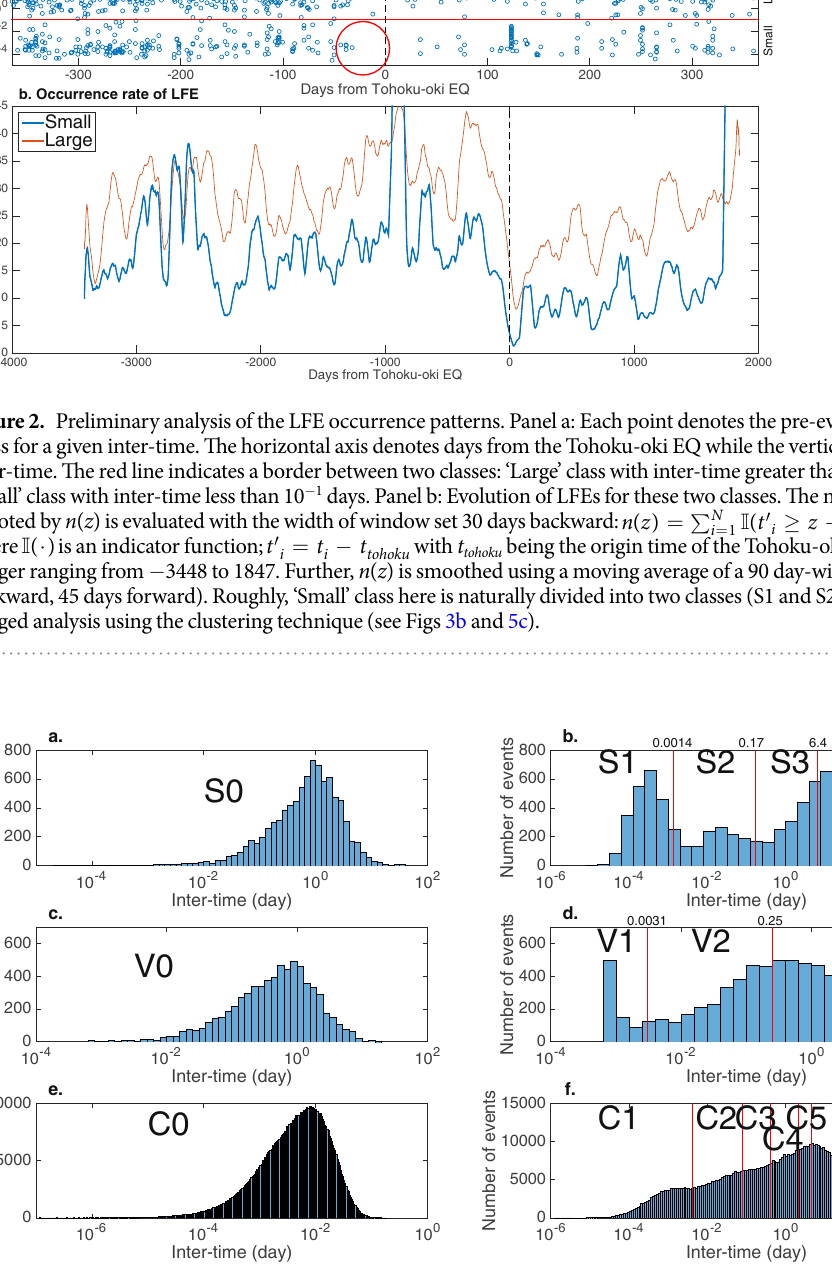
Figure 3. Distribution of inter-times between earthquakes. Panel a: Inter-time distribution of remote pairs of LFEs. Panel b: Inter-time distribution of neighboring pairs of LFEs. Red lines denote borders between four classes S1, S2, S3, and S4, which were yielded by fitting Gaussian mixture models to the logarithm of inter- time. Cutoff days for these borders are shown in the top of the panel. Panel c: Inter-time distribution of remote pairs of volcanic tremors. Here, we define ‘remote’ as different volcanoes. Panel d: Inter-time distribution of neighboring volcanic tremors, where the definition ‘neighboring’ denotes same volcano. Red lines denote borders between three classes V1, V2 and V3. Panel e and f: Inter-time distribution for conventional